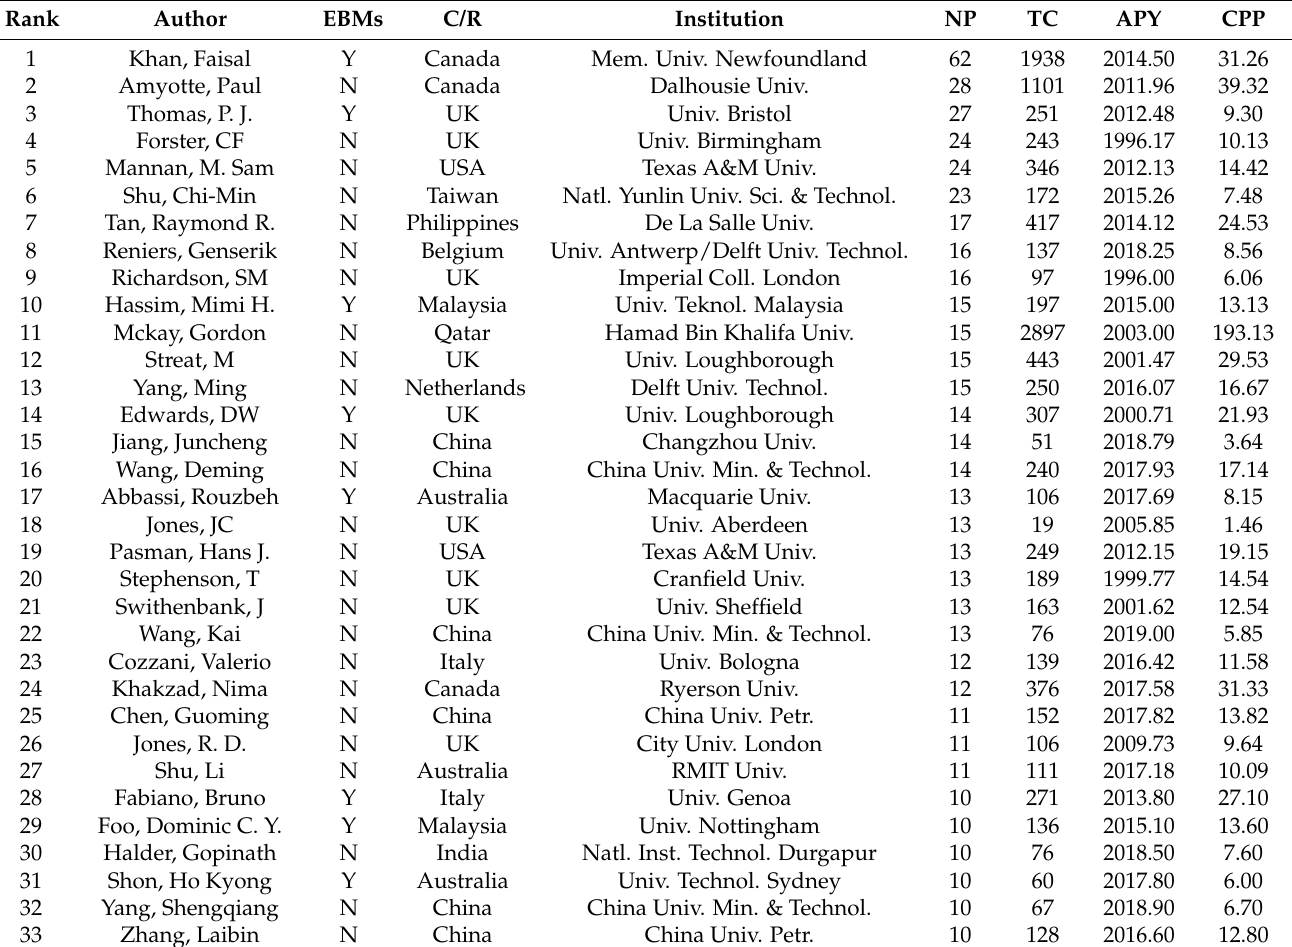
Table 2. Leading authors in PSEP based on the number of publications (minimum number of publications =